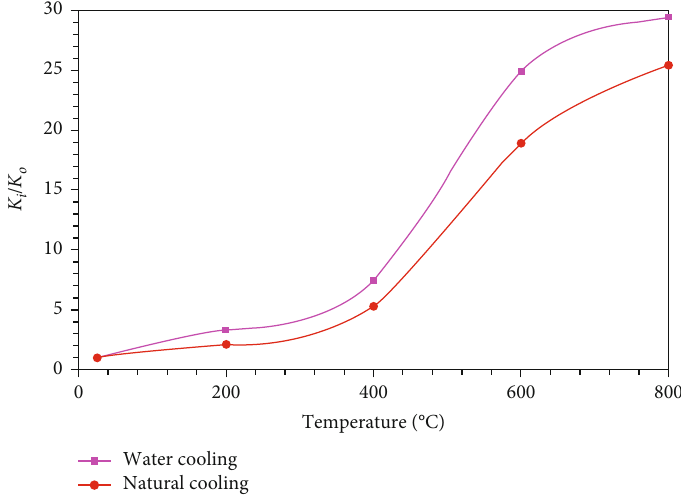
Figure 4: The variations of permeability of core samples with temperature under two di ff erent cooling